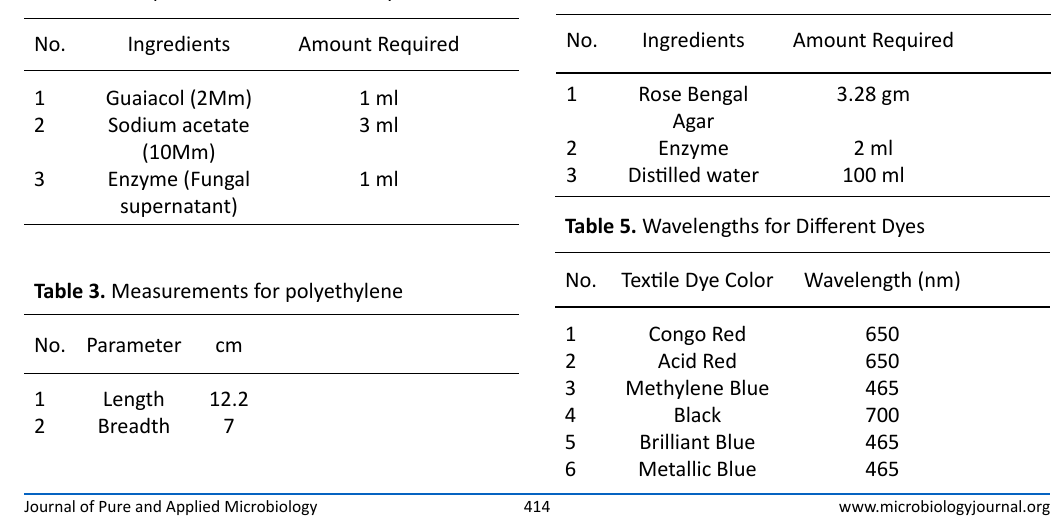
Table 4. Composition for Biodegradation assay